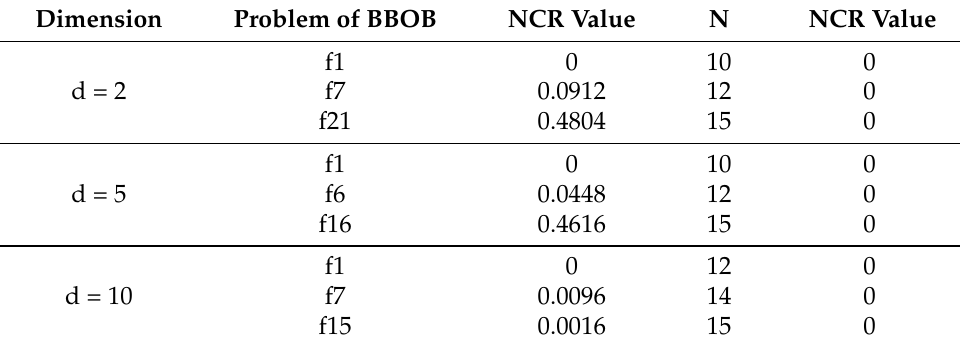
Table 1. The NCR values of problem instances from BBOB and the proposed generator at differ- ent